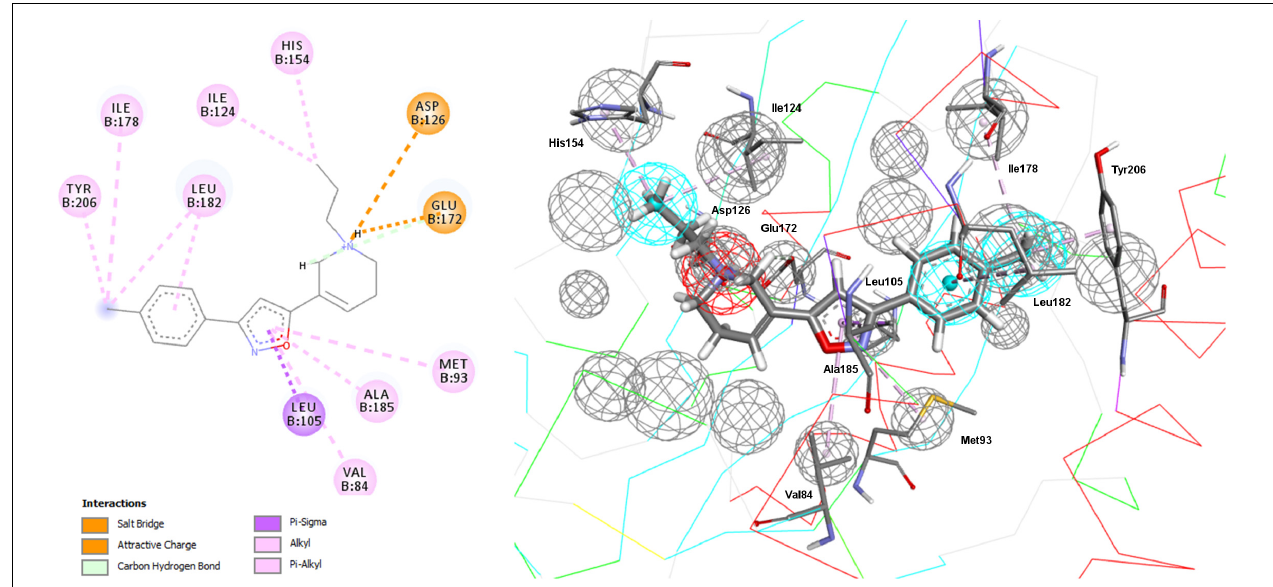
FIGURE 2 | New pharmacophore model 5HK1–Ph.A based on receptor-ligand interactions. The model consists in one PI feature (red), three HYD features (blue), and twenty-one Excluded Volumes